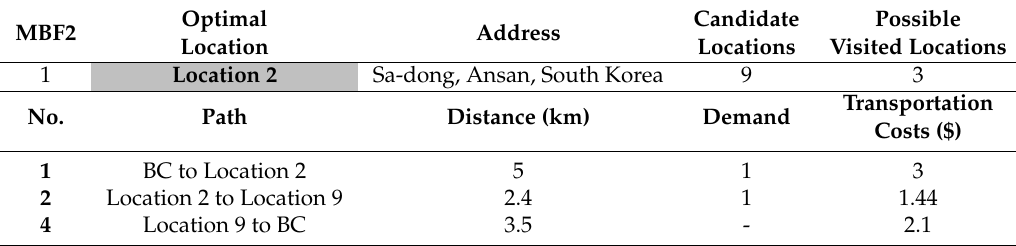
Table 6. The optimal location and navigation path of